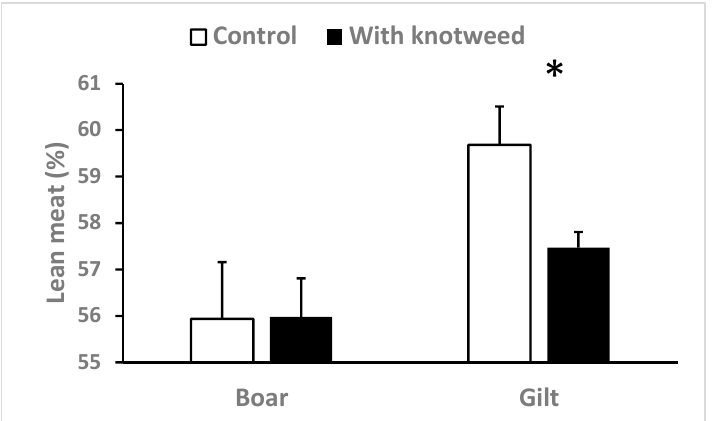
Figure 3. The content of lean meat (muscle) measured by ultrasound in pigs fed on a feeding mixture with the knotweed additive in comparison to pigs fed on a common feeding mixture, separated according to sex. Means + SEM. Difference significant on p < 0.05 marked by an asterisk. In accordance with the higher recorded weight of gilts fed on knotweed (Figure 2), a greater amount of back fat and muscle (Figure 4) was recorded for the same group compared to a control group using a thorough analysis of a carcass. Knotweed feeding positively affected the amount of back fat in gilts; the average height of lard was 15.4 mm, whilst in boars, the back fat height was around 22.75 mm. No significant ( p > 0.05) difference in the height of back fat between boars from the control and experimental group was recorded; however, in gilts from the control group, back fat was about 5.15 mm lower ( p < 0.05) than in gilts from the experimental group (Figure 4). Thus, the reduced content of lean meat in gilts fed on knotweed was caused by the higher quantity of lard (50.24%) rather than by the quantity of muscle (13.10%).